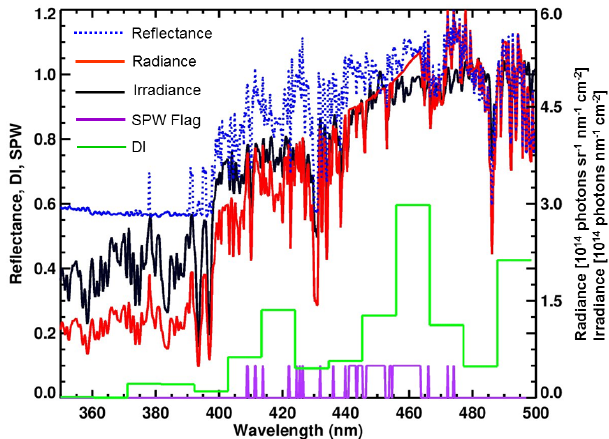
Figure 5. Similar to Fig. 2 but for pixel iTimes 824, row 15, orbit 7987 indicated by arrows in Fig. 4c, d showing solar glint from Salar de Uyuni.